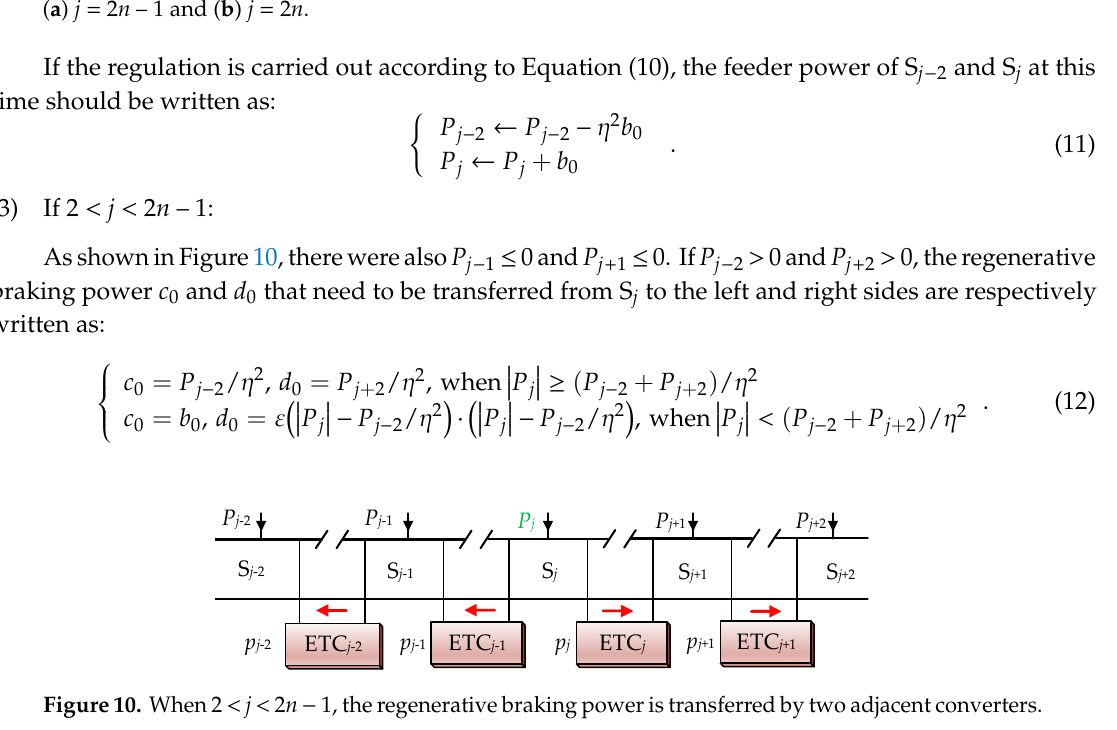
Figure 9. When j ≥ 2 n − 1, the regenerative braking power is transferred by two adjacent converters: ( a ) j = 2 n – 1 and ( b ) j = 2 n .